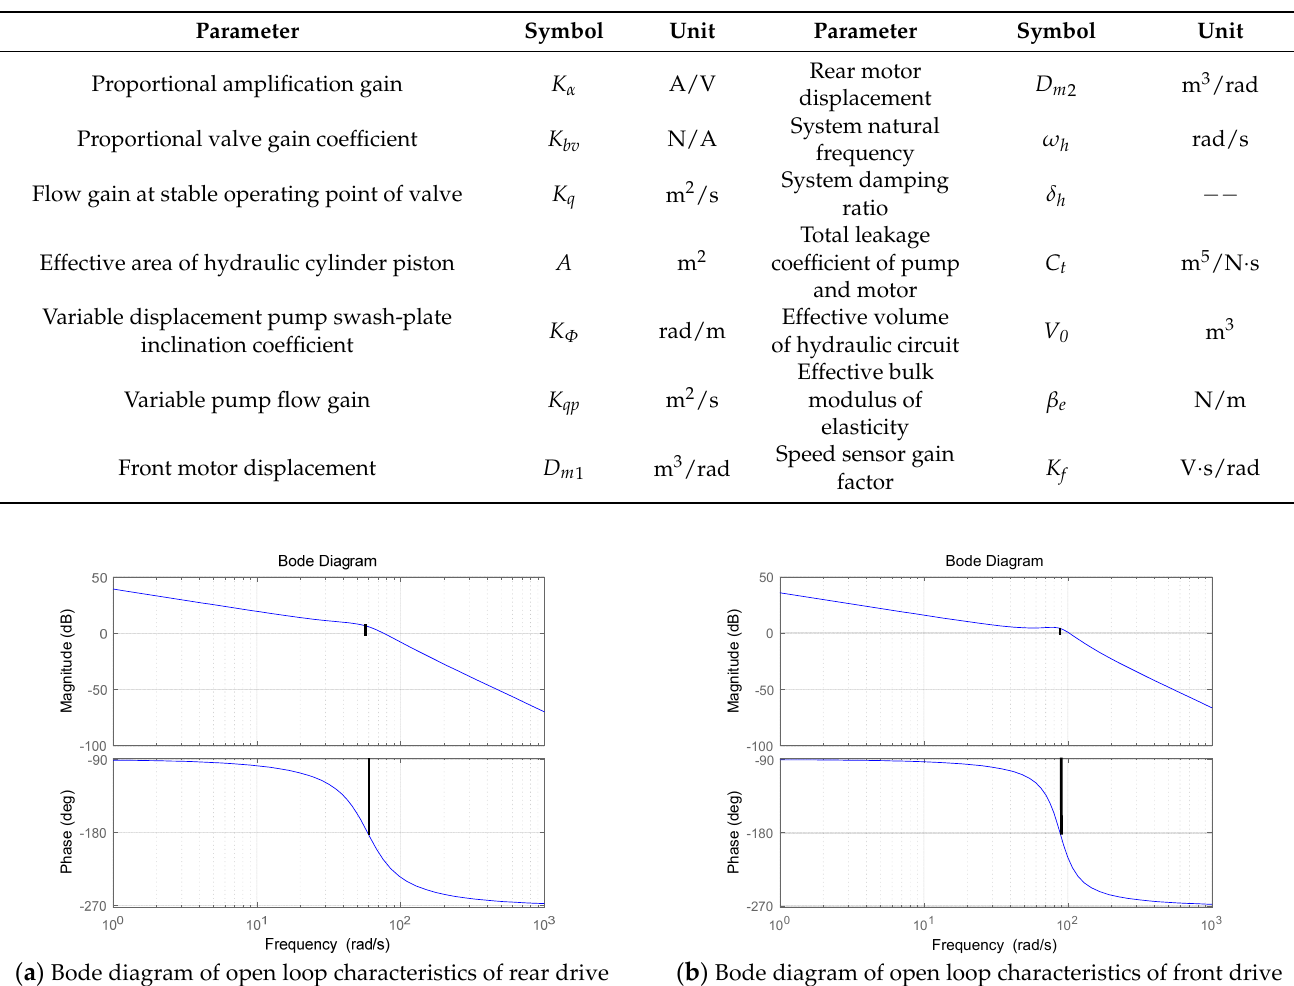
Table 1. Parameters of pump-controlled motor mathematical model.